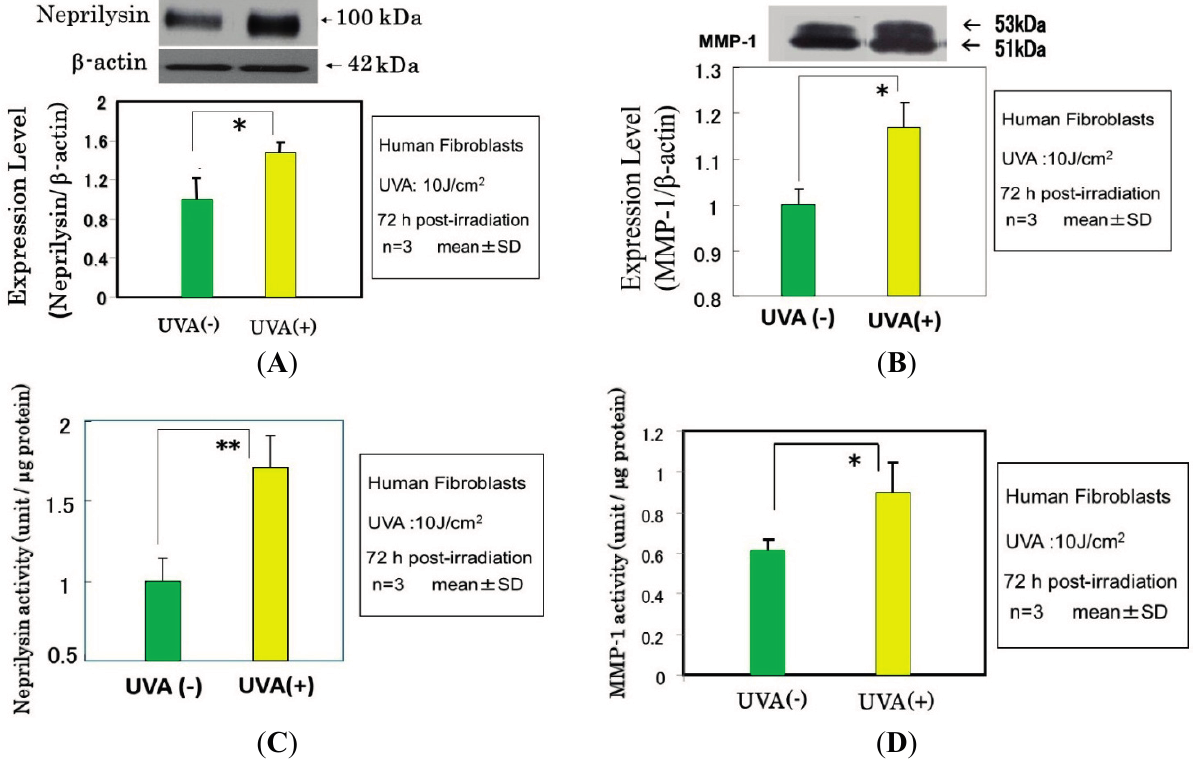
Figure 10. Effects of UVA radiation on the protein and activity levels of neprilysin (NEP) ( A , C ) and MMP-1 ( B , D ) in cultured human skin fibroblasts as revealed by western blotting analysis. * p < 0.05, ** p <